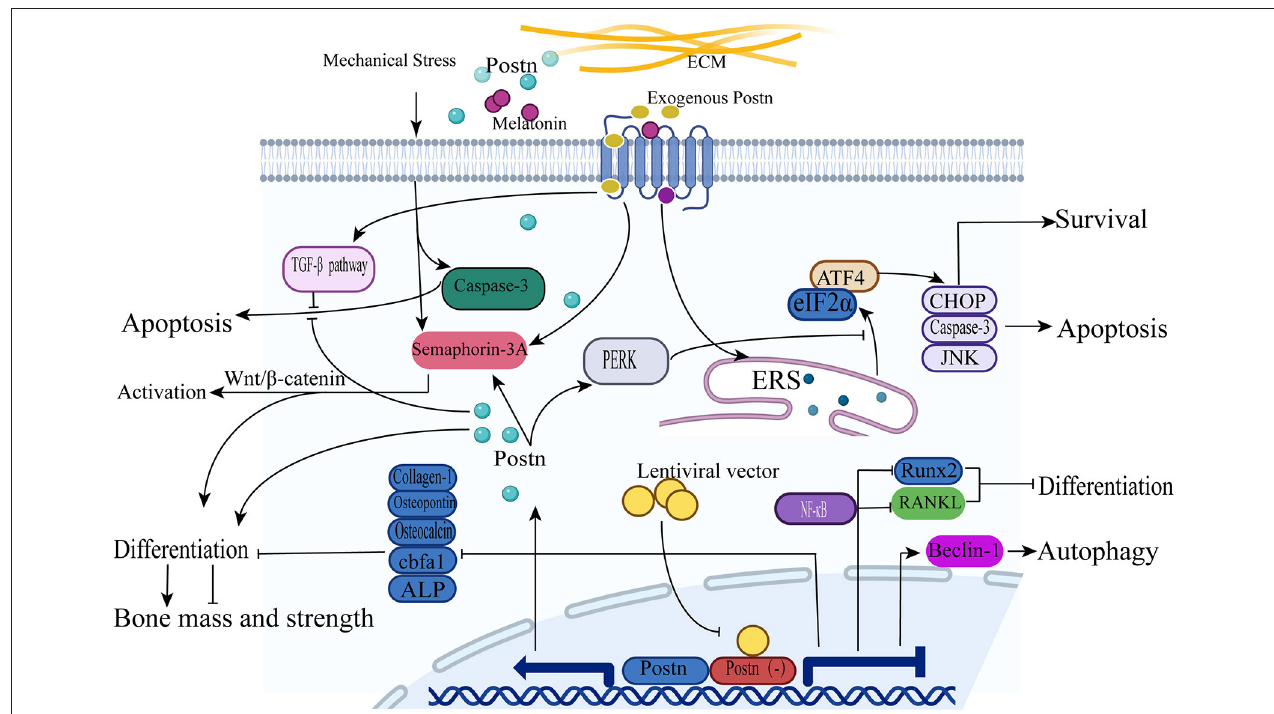
FIGURE 3 | POSTN induces osteoblast differentiation, survival, and apoptosis. (1) Upon treatment with recombinant POSTN, the expression of semaphorin 3A is increased and promotes the activation and differentiation of osteoblasts through the Wnt/ β -catenin signaling pathway. (2) The intensity of osteoclast apoptosis signals is weakened by POSTN expression through the TGF- β signaling pathway under a high level of mechanical stress. (3) The expression of the autophagy-related protein beclin 1 in osteoblasts is increased after POSTN silencing. (4) The expression of the proteins RUNX2 and RANKL is significantly reduced after POSTN gene silencing through the activation of the NF- κ B signaling pathway. (5) Osteoblast apoptosis is induced by melatonin through the activation of the ERS-eIF2 α -ATF4 pathway; subsequently, the cascade effects of CHOP, caspase 3, and JNK are triggered to promote apoptosis. POSTN overexpression can inhibit the eIF2 α -ATF4 pathway by suppressing the PERK pathway to protect osteoblasts from